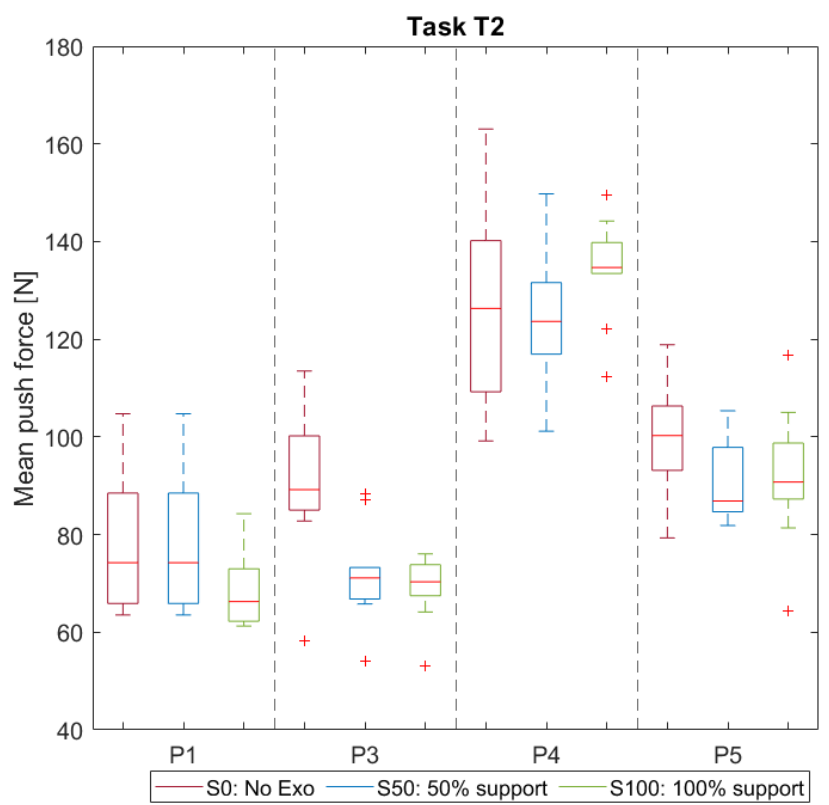
Figure 7. Mean push force of segment screw from T2 and all three support conditions (S0, S50, S100) of participants P1, P3, P4, and P5. The boxes represent the interquartile range (IQR). The length of whiskers is IQR*1.5. Outliers (>IQR*1.5).